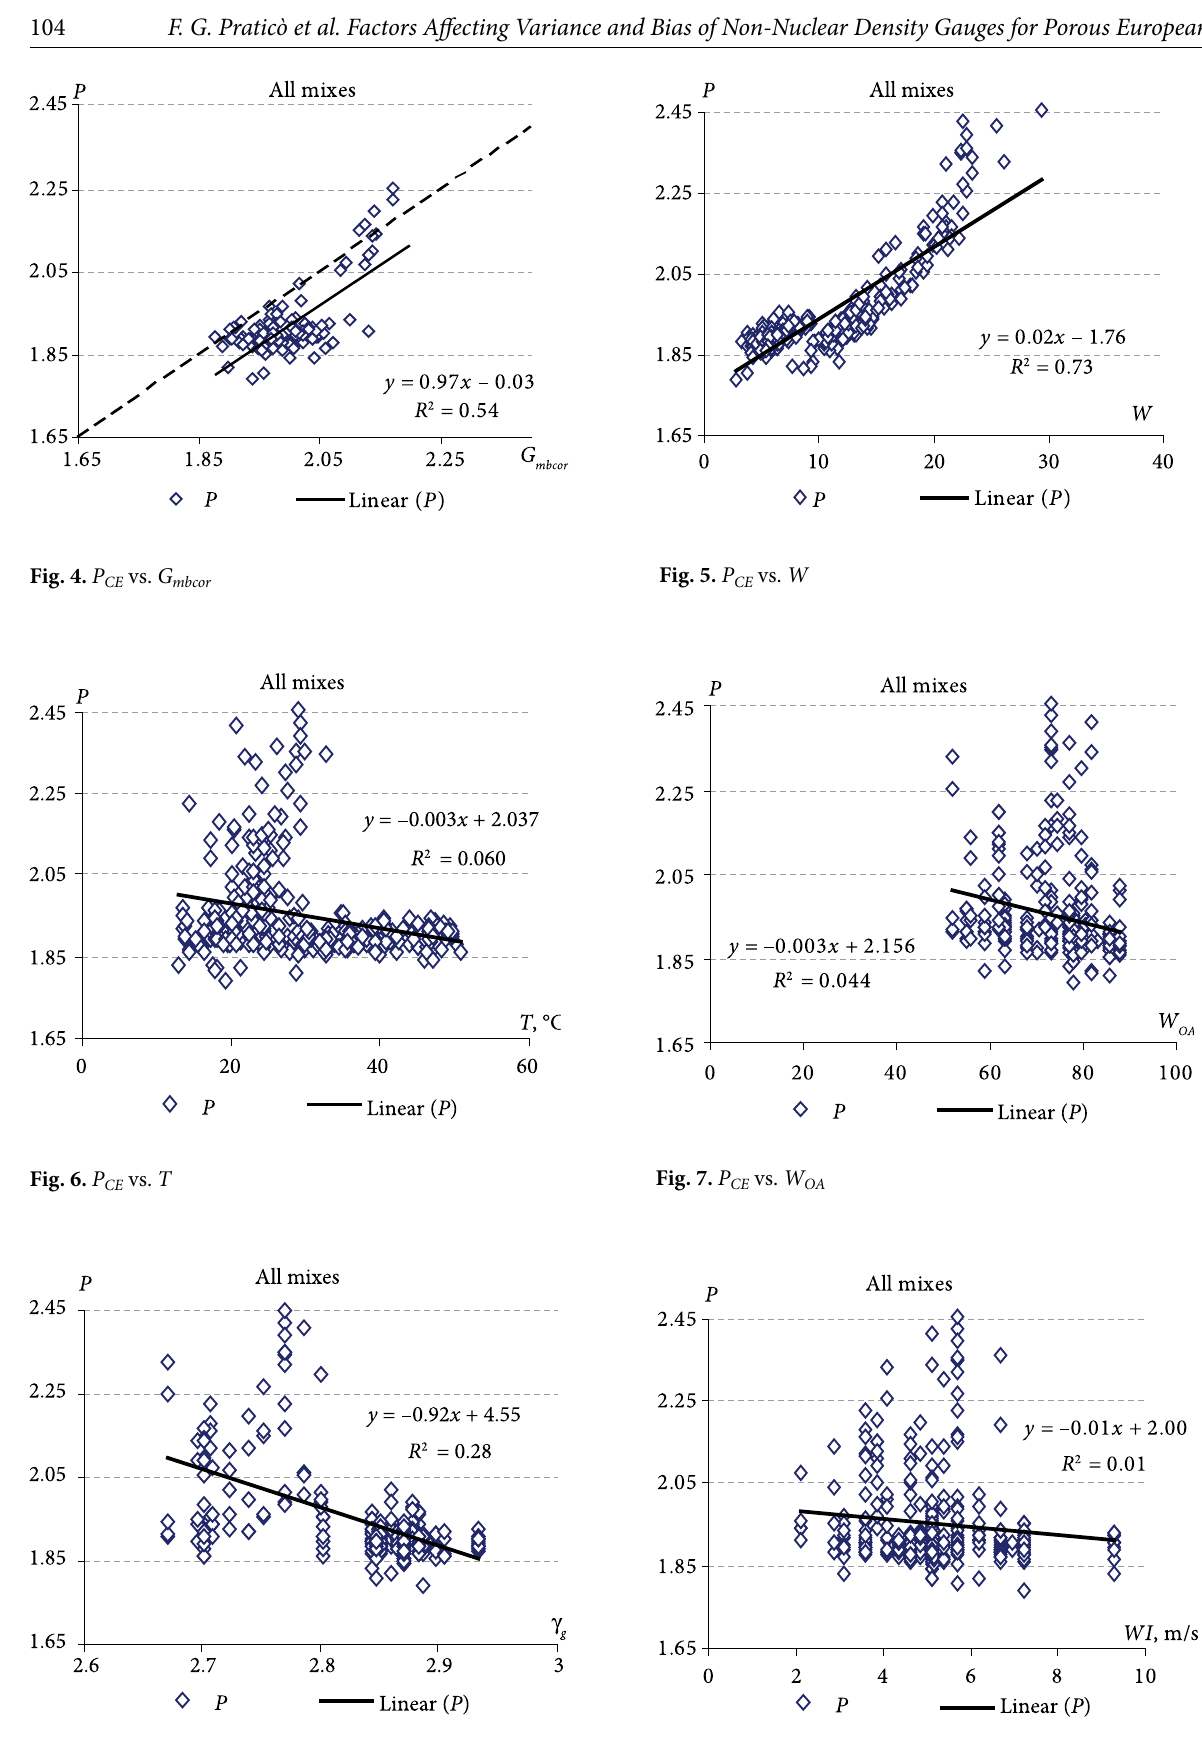
Fig. 9. P CE vs. WI